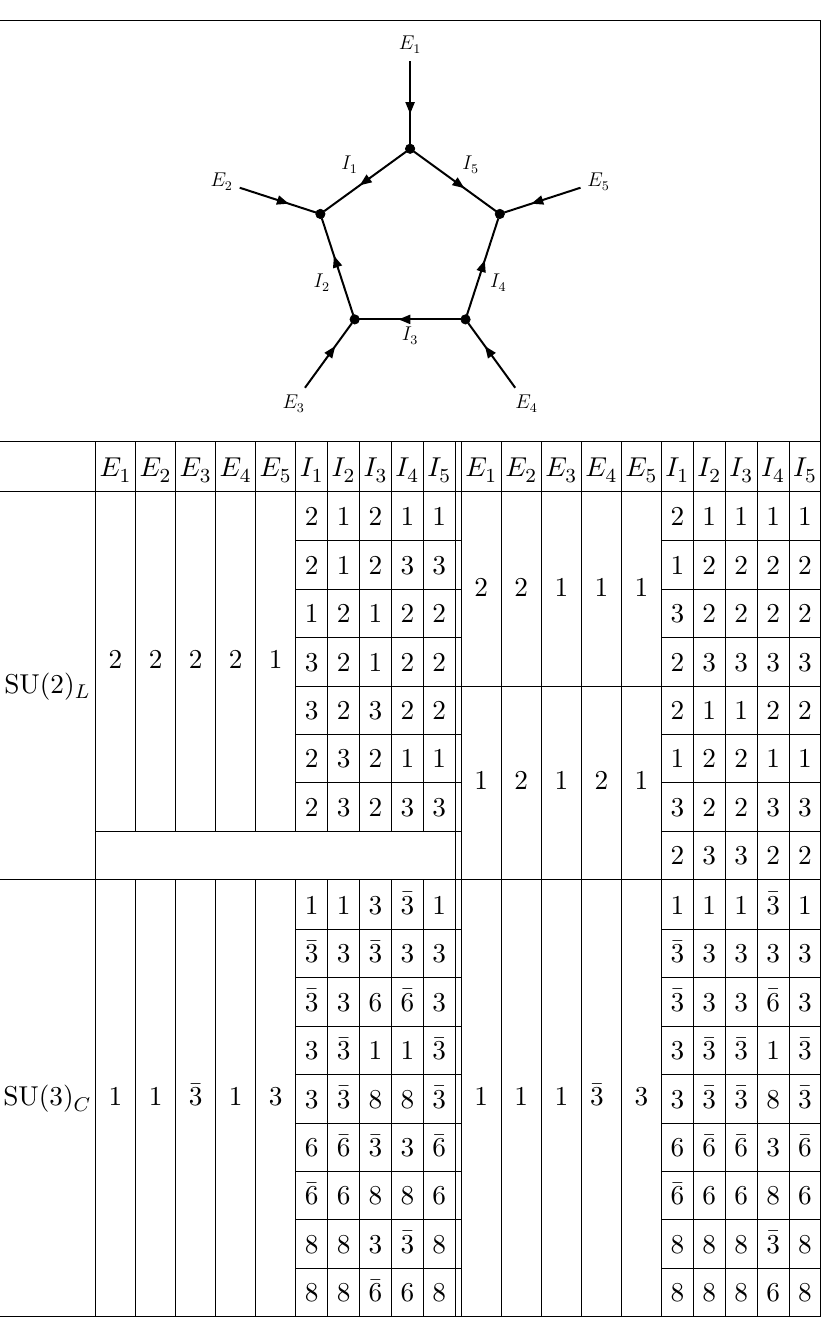
Table 8 . The independent SU(2) and SU(3) quantum number assignments for the topology L C NL-1-3, where E and I denote the external fields and internal fields respectively. Other assignments i i are related to these in the table through permutations of external and internal